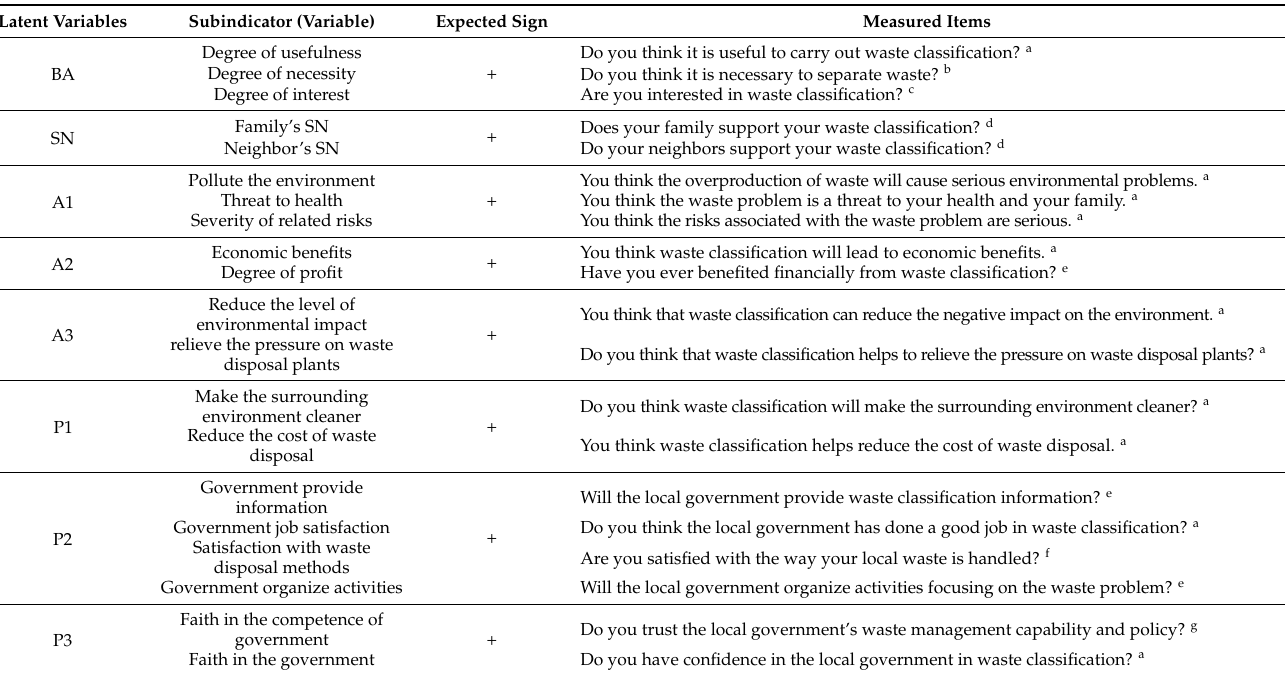
Table 2. Attitude, awareness, perception, and other related measurement